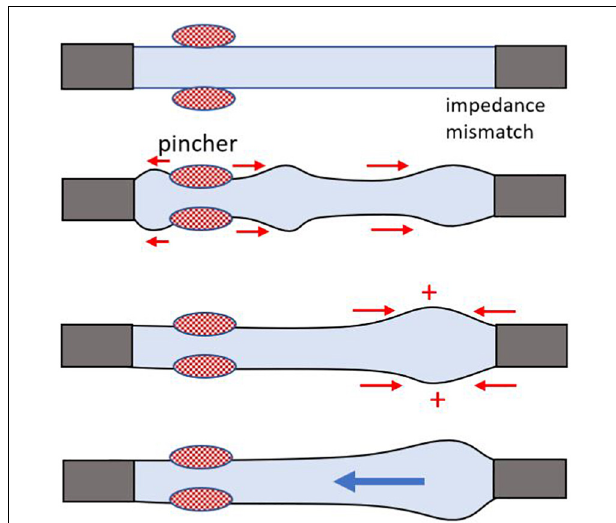
FIGURE 2 | Cartoon illustrating mismatch of impedance that creates a wave reflection site, leading to a one-way flow. A general cartoon of Liebau’s principle for an open tube system. Rhythmic compressions of the flexible tube in the middle do not generate flow, while asymmetrically positioned pinch sites yield a one-way flow. The mismatch of impedance at the junction of the two tubes with different wall compliance creates a wave reflection site, a necessary condition to achieve pumping. Flow direction depends on the compression frequency, geometry, and physical properties of the